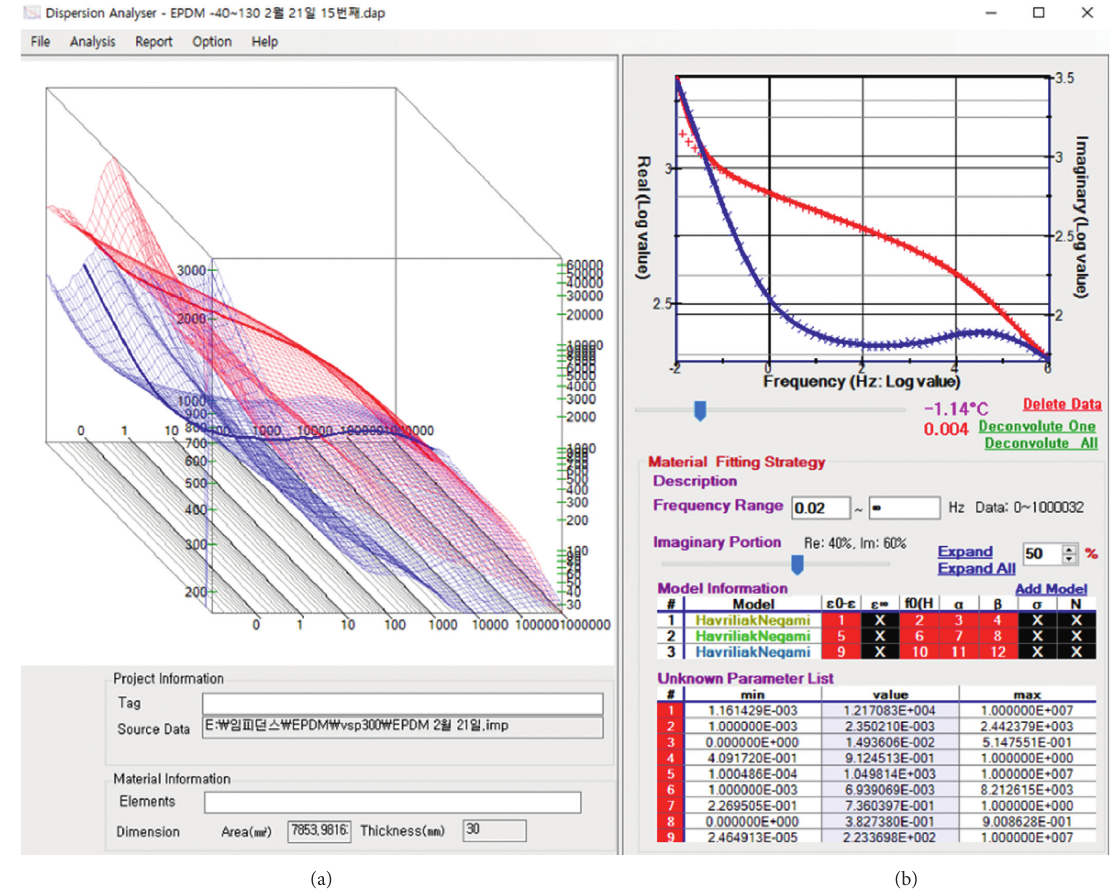
Figure 8: An example of the decomposition of relaxation spectra by the dispersion analysis program at 272K in EPDM. (a) Real (red line) and imaginary (blue line) fitted permittivity line versus frequency for all temperatures and (b) the decomposition of three relaxation processes by the dispersion analysis program. In (b), the measured data of the real (red × ) and imaginary (blue × ) permittivity and the fitted real (red line) and imaginary (blue line) permittivity graphs at 272K are shown, and their fitted parameters are listed in the bottom